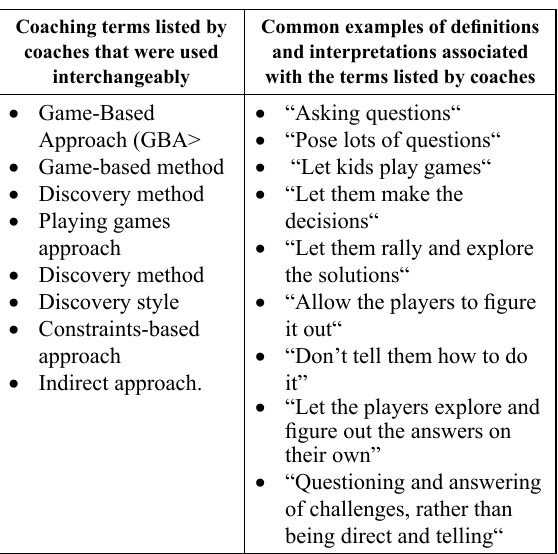
figure out the answers on their own” of challenges, rather than being direct and